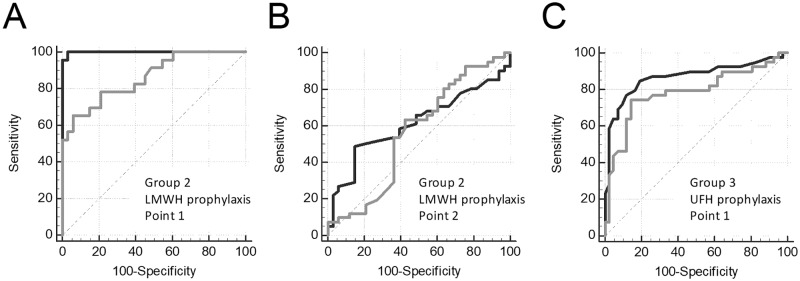
Heparin effect on TEG vs TD.ROC curves for alpha in TEG (gray lines) and V in TD (black lines) for prophylaxis with LMWH (group 2) at Point 1 (A) and Point 2 (B) or UFH (group 3) at Point 1 (C). Data of the same patients before the first heparin injection were used as controls.